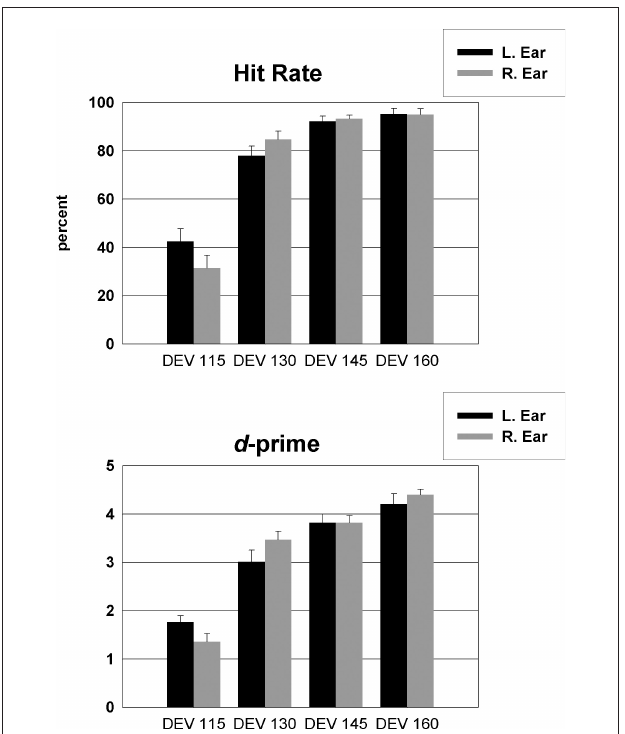
FIGURE 1 | Percent Hit-rates (top panel) and d -prime values (bottom panel) for each degree of temporal deviant and ear of delivery in the behavioral task.